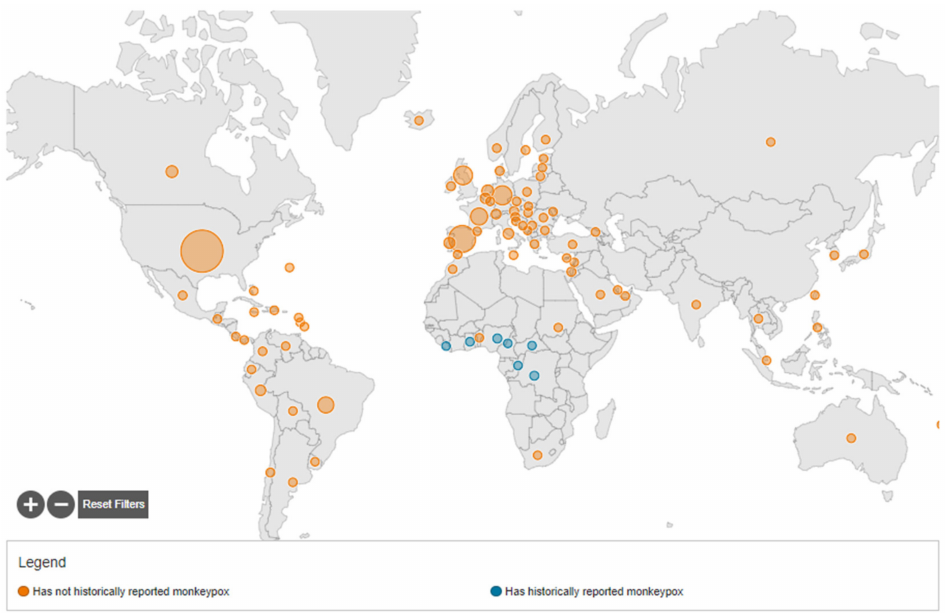
Figure 2. Describes the geographical distribution of monkeypox virus